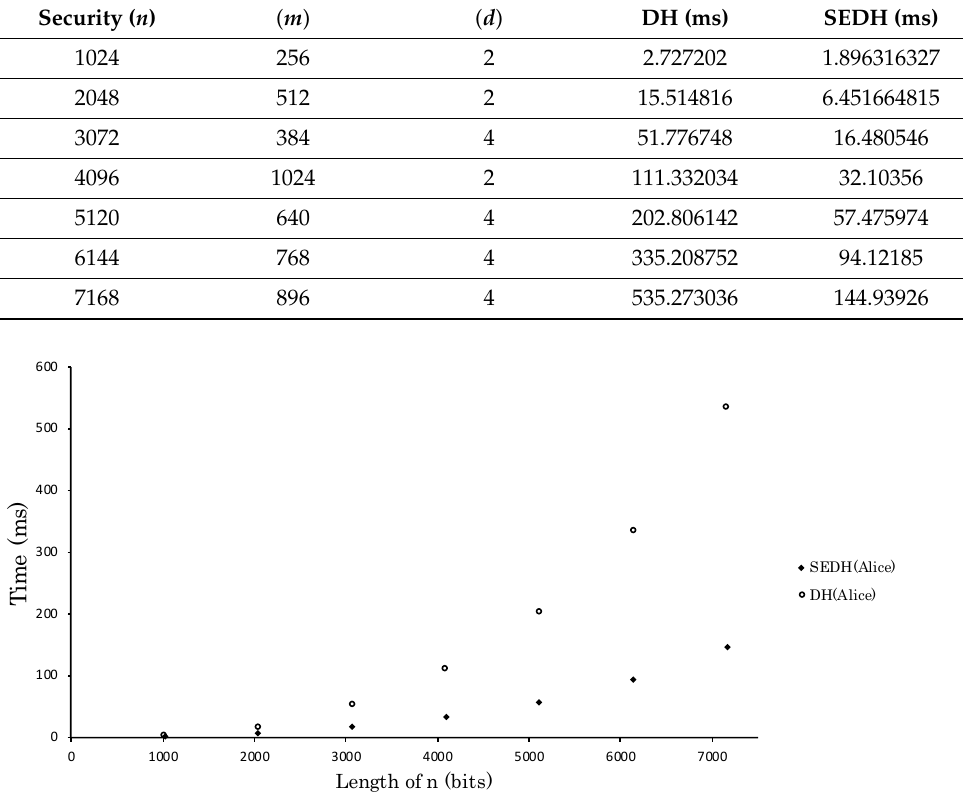
Table 10. Comparison of calculation times (ms) for Alice with DH.